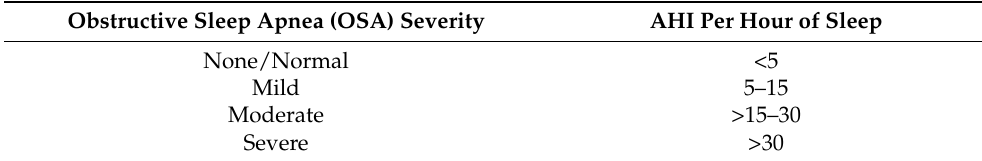
Table 1. The Apnea-Hypopnea Index